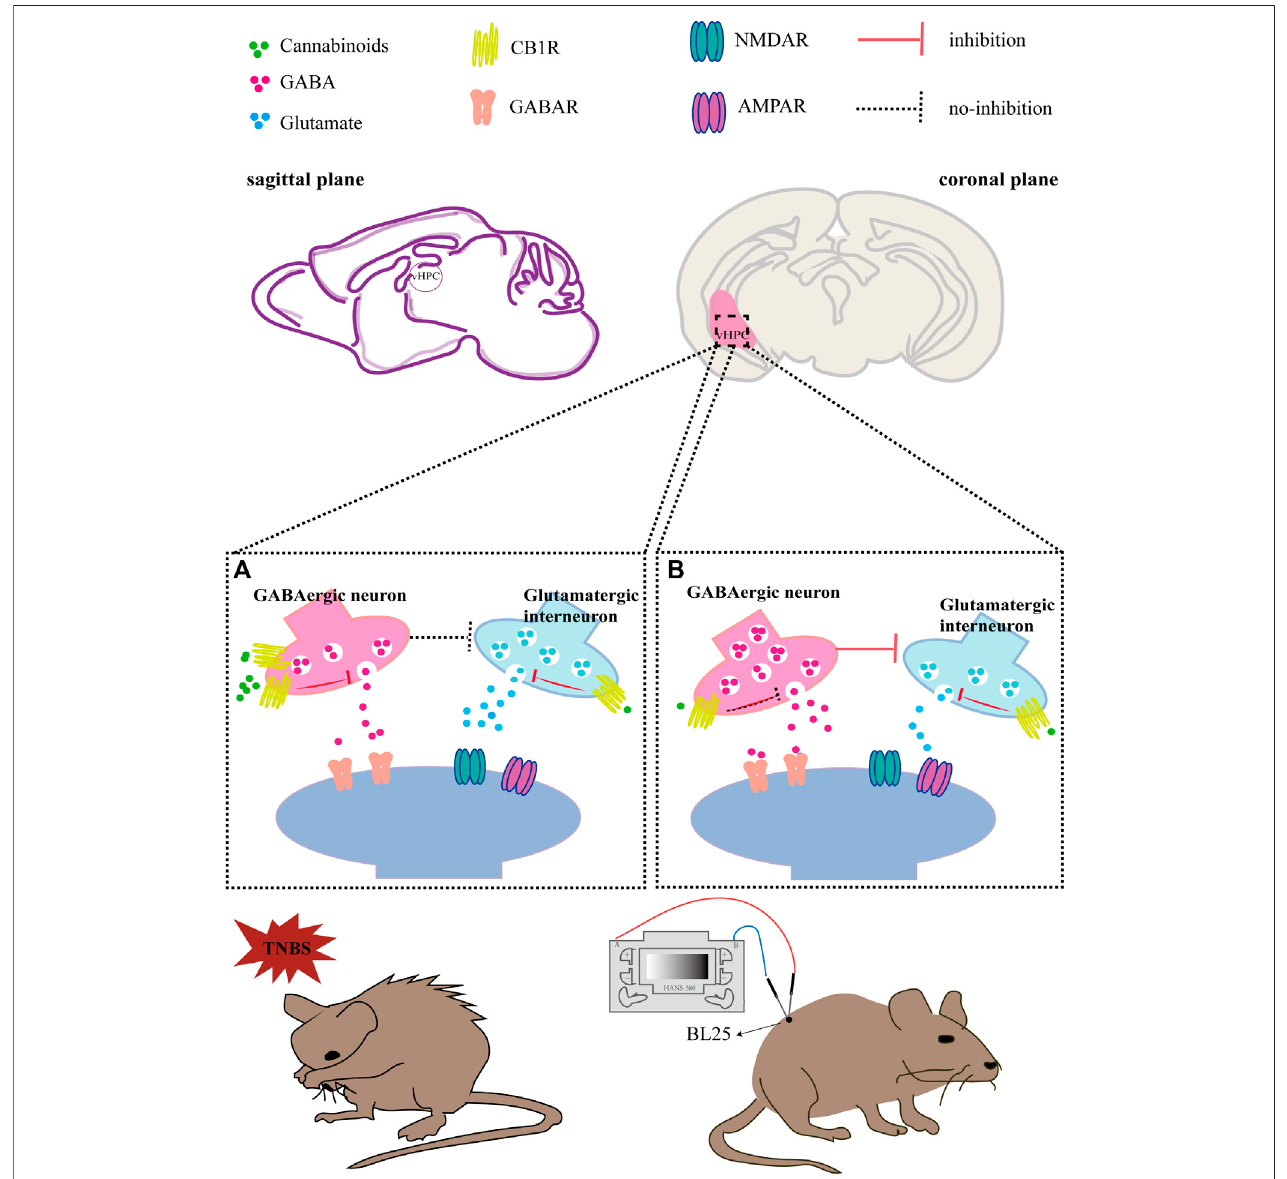
FIGURE 7 | Hypothesis diagram of EA inhibiting IBD induced anxiety via CB1R in the vHPC. (A) In TNBS-induced IBD mice, CB1R was over-expressed in GABAergic neurons in thevHPC,which wasactivated by endocannabinoid and the release amount ofGABAwasreduced. Asaresult, therelease amount ofglutamate is increased because of decreased inhibition of GABA. The increased release of glutamate in the vHPC may excite anxiety-related neuronal circuits starting from vHPC, thus inducing anxiety-related behaviors in IBD mice. (B) In TNBS-induced IBD mice with EA treatment, EA downregulated CB1R in GABAergic neurons in the vHPC,whichdisinhibitthereleaseofGABA.Inturn,excessiveGABAinhibitedthereleaseofglutamate.Meanwhile,CB1Ringlutamatergicneuronscanalsobeactivated by EA induced endocannabinoid, which can also decrease the release amount of glutamate. To sum up, EA may exert anxiolytic effect via downregulating CB1R in GABAergic neurons and activating CB1R in glutamatergic neurons in the vHPC, thus reducing the release of glutamate and inhibiting the anxiety-related neuronal